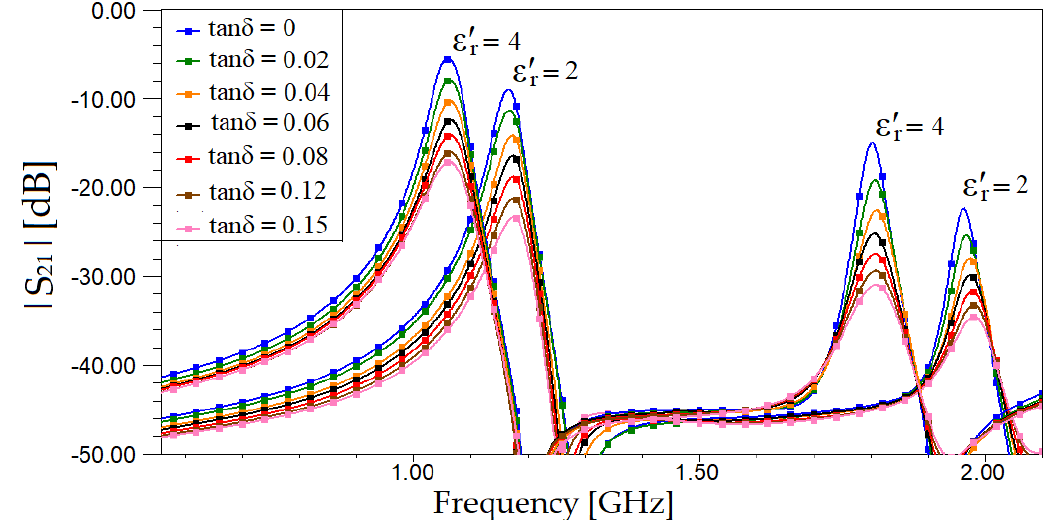
Figure 5. Variation of S 21 (dB) response of the VS-SRR sensor with loss tangent value varying from 0 to 0.15 and for values of the relative electric permittivity, ε ʹ r equal to 2 and 4.